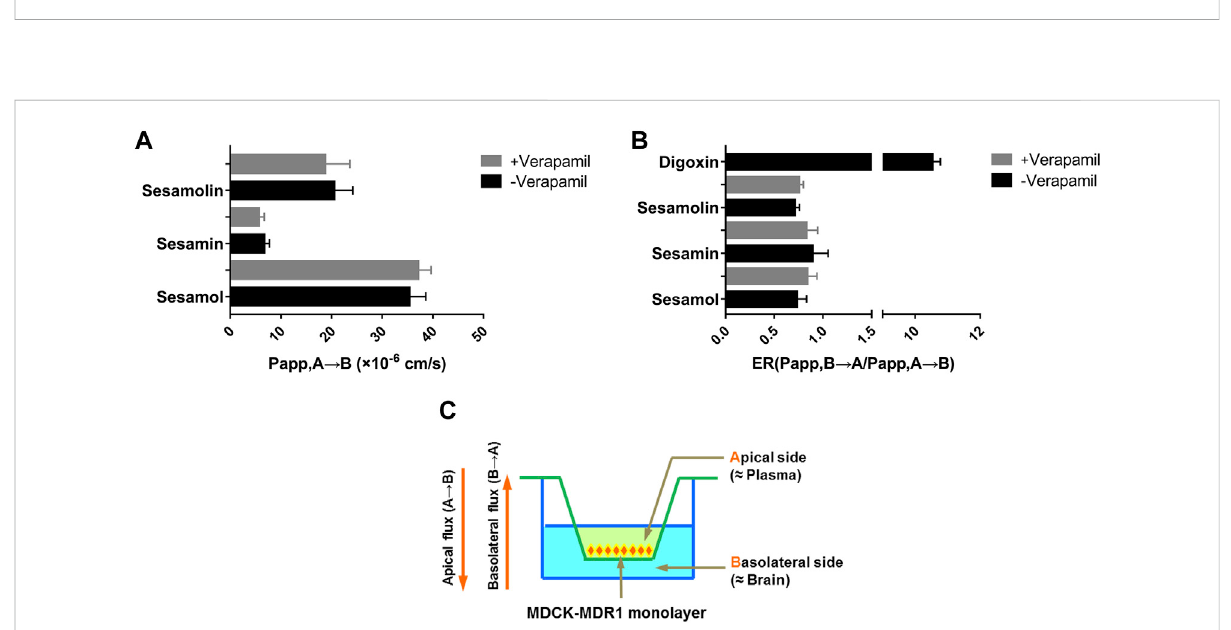
FIGURE 6 Membrane permeability (A) and ef fl ux ratio (B) of sesamin, sesamolin, and sesamol across the MDCK-MDR1 monolayer (C) . Data are expressed as the mean ± SD ( n =